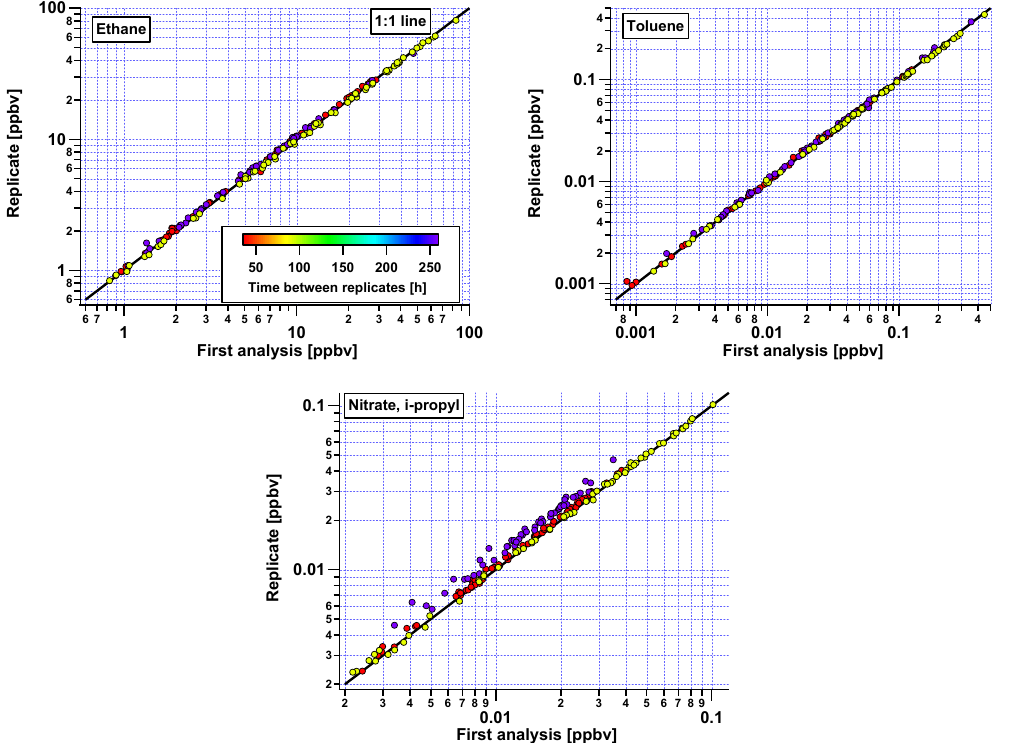
Figure 9. Comparison of replicate analyses from the same sample canister sets from three flights during SONGNEX 2015 (flight dates: 9, 13, 23